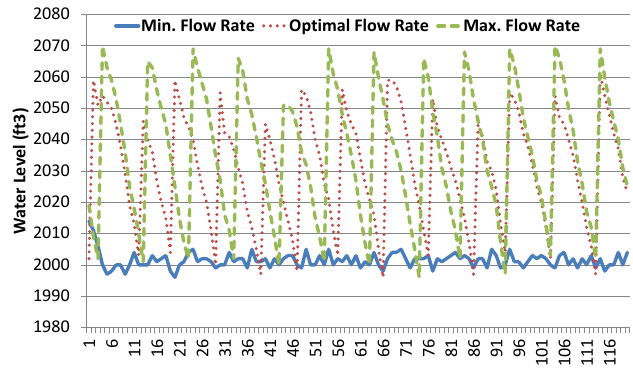
Figure 13. Desired water level maintenance results by the three